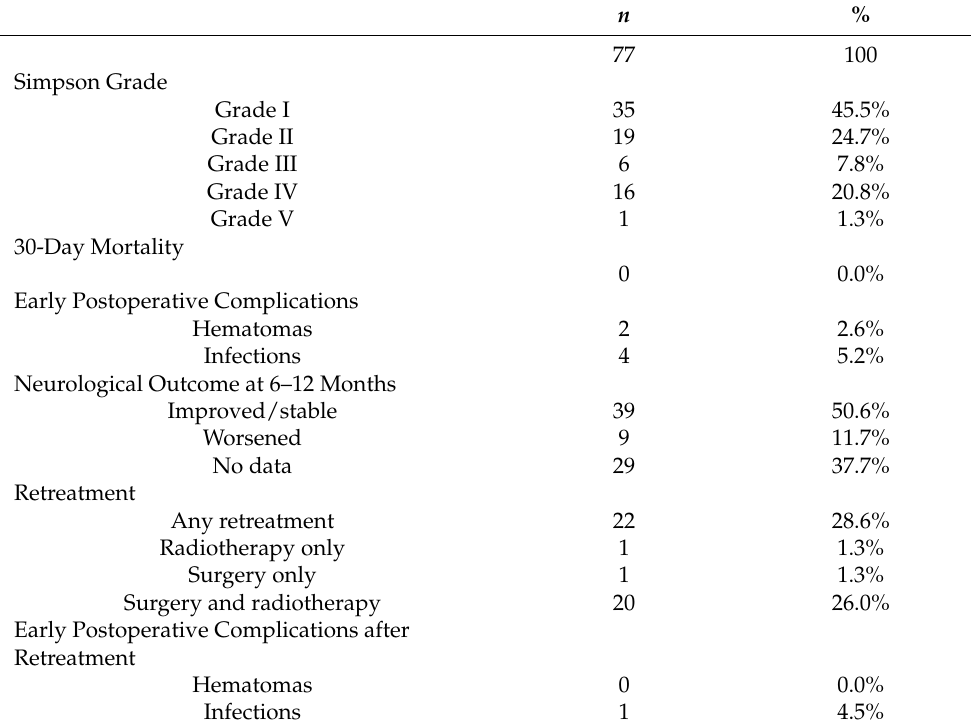
Table 2. Therapeutic management of atypical meningiomas.